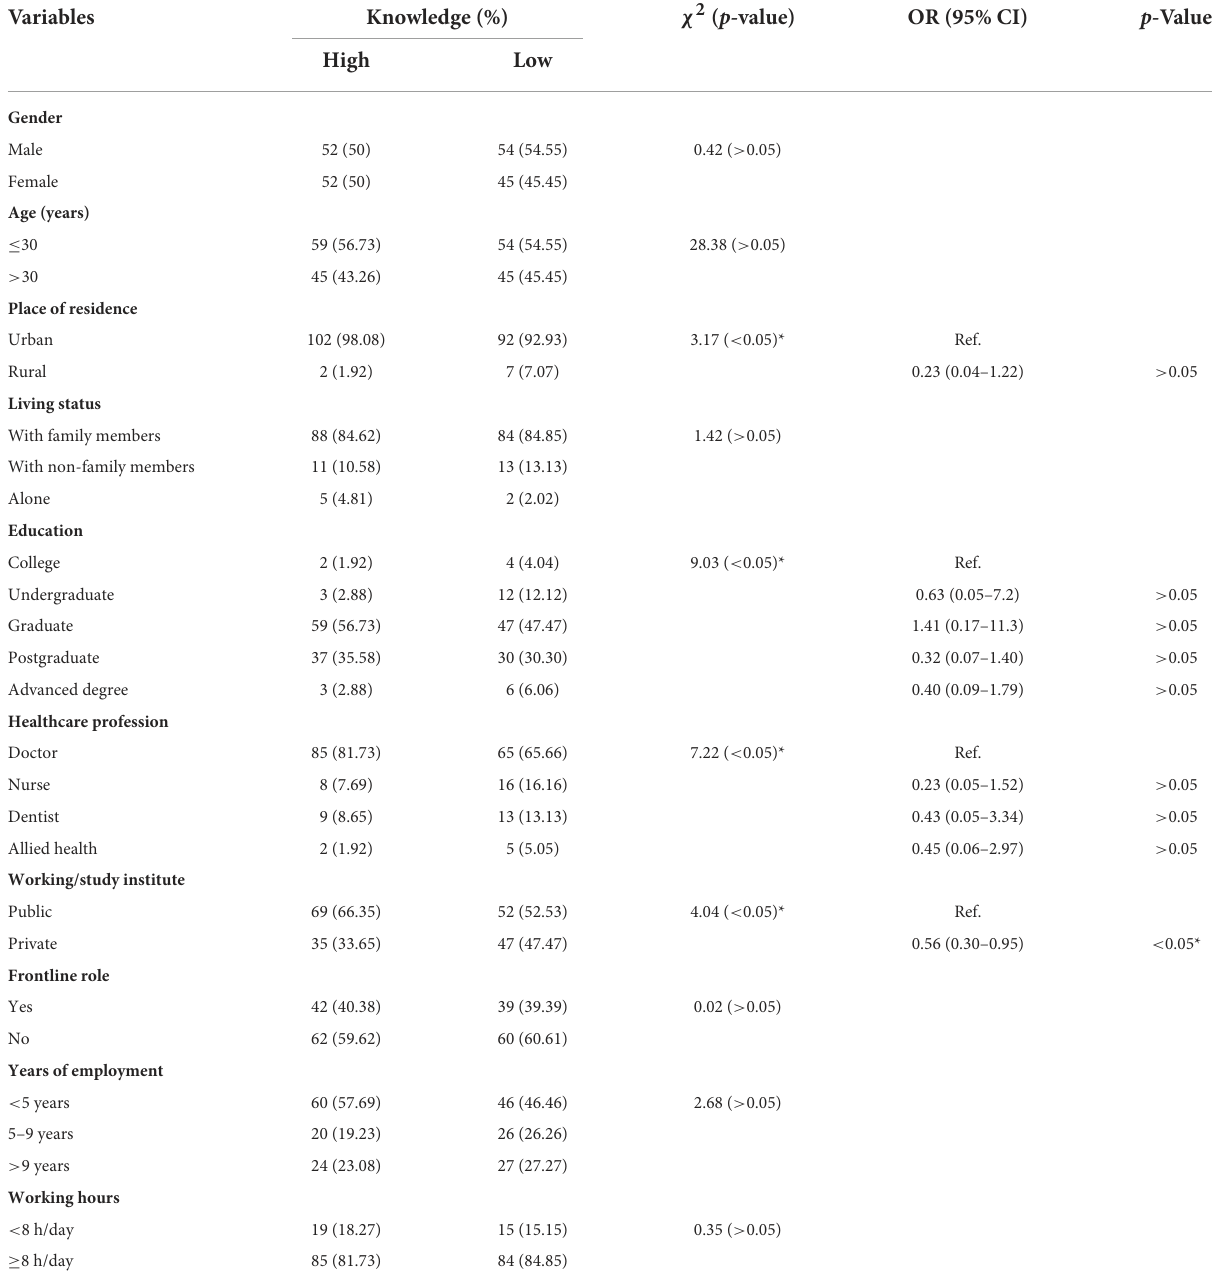
TABLE 5 Factors influencing knowledge levels regarding COVID-19 among healthcare